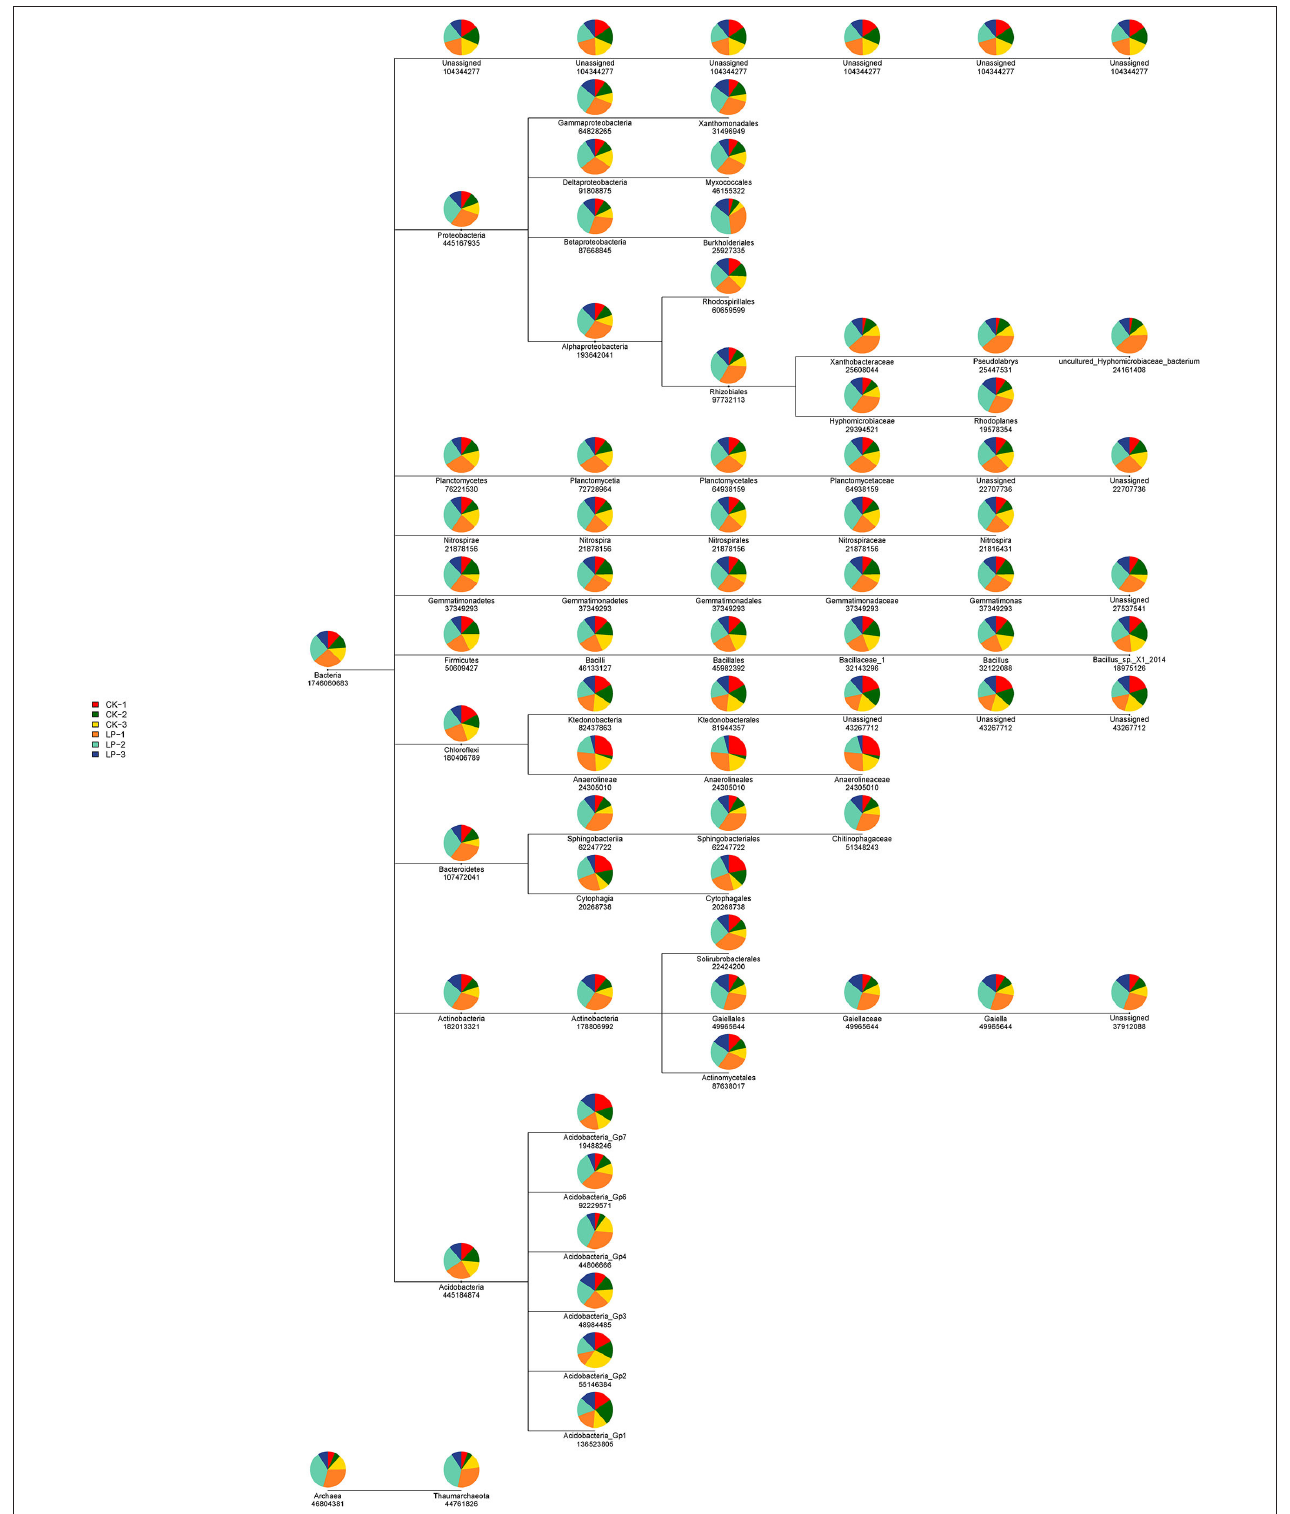
FIGURE 2 | The phylogenetic tree of intercropping and monoculture groups. The phylogenetic tree, from the leftmost root node to the rightmost leaf node, each layer represents a classification level from boundary to species level. For species at each level, a pie chart is used to show the proportion of the species in each sample (the proportion > 1%), different colors represent different samples, and the larger the fan area of a color, the larger the number of sequences. The numbers under the circle represent the sum of the sequences of the species in all samples.